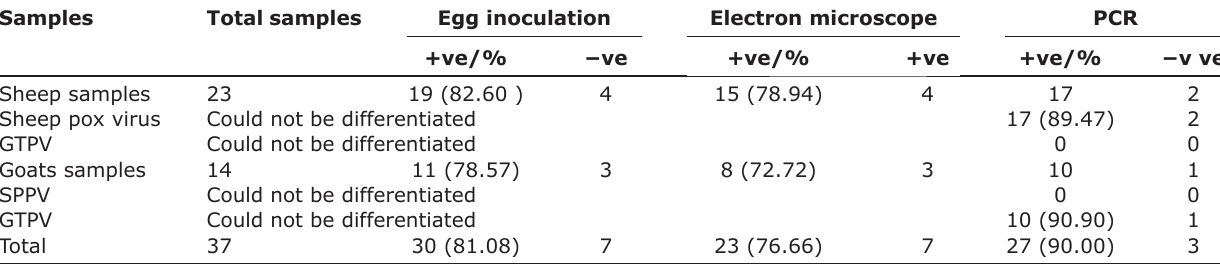
Table-1: Results of isolation of SPPV and GTPV by inoculation on embryonated chicken egg, electron microscope, and 30 kDa RNA polymerase subunit (RPO30) gene-based PCR. Samples